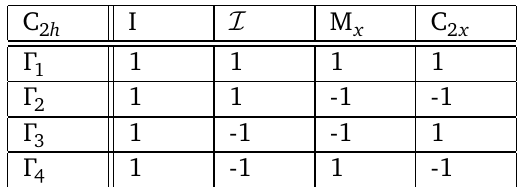
point group. Γ ’s are the irreducible representations i 2 h